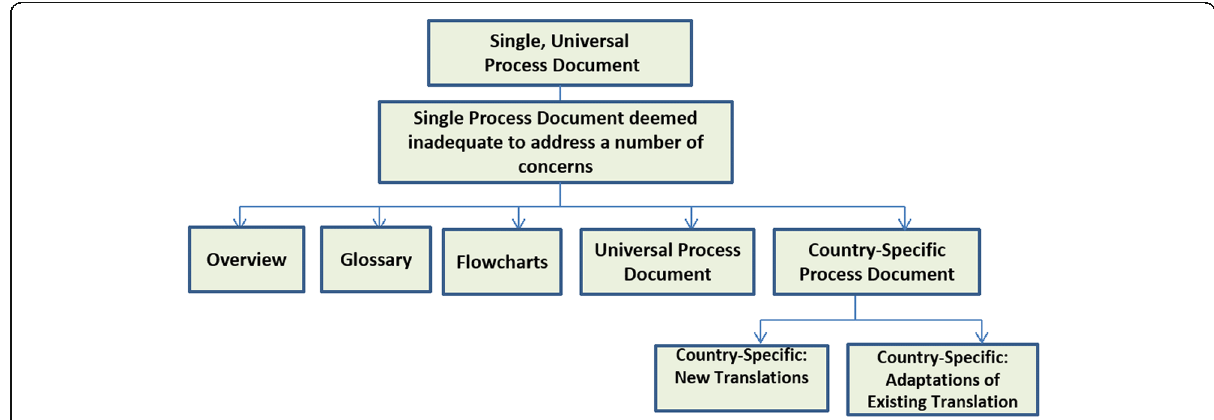
Fig. 1 Overview of PRO Consortium Translation Process